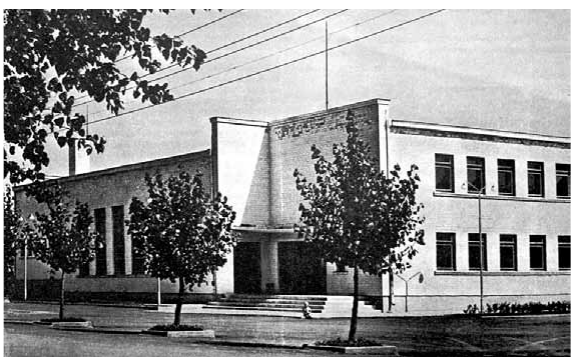
5 pav. Šilalės raj. K. Požėlos kolūkio (dab. Kaltinėnai?) kultūros namai, 1968 m. Fig. 5. House of Culture in „K. Požėla“ collective farm (now Kaltinėnai?), Šilalė region,